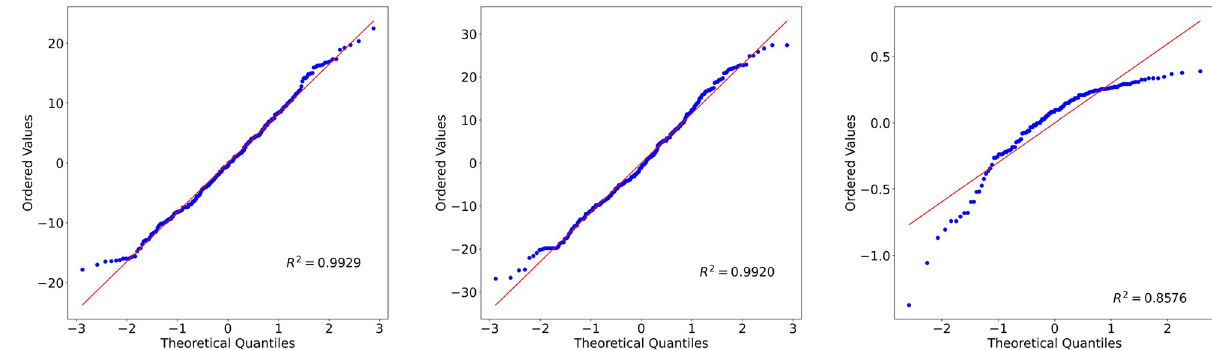
Fig 5. Probability plots for Phase 1 data. (A)Emotion (B)Rater gender (C)Speaker gender data.